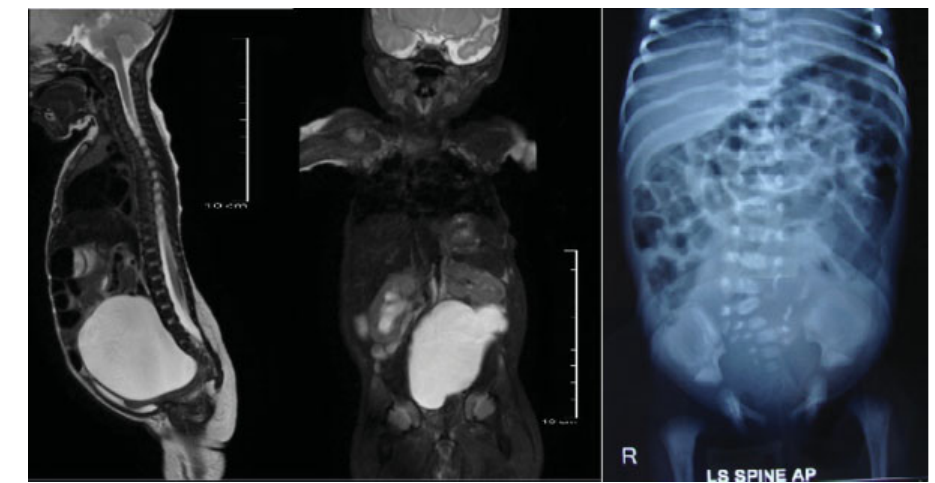
Fig. 2 Histopathology demonstrated a large cystic teratoma with mature renal elements in the wall (inset).